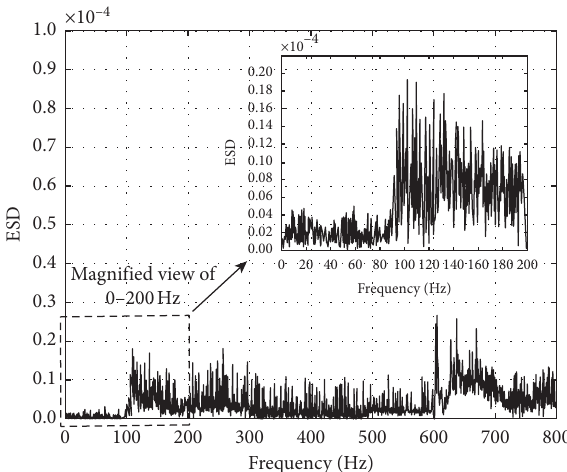
Figure 9: Marginal spectrum of the radial seismic wave